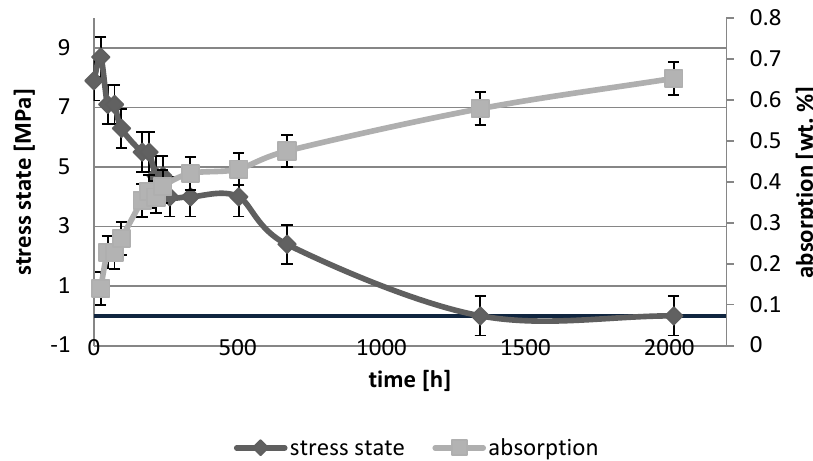
Figure 8. The relationship of absorption and stress state during water ageing (2016 h) of Twinky Star.